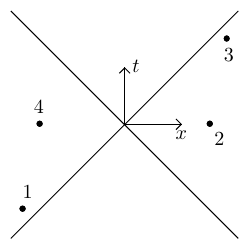
Figure 1. Regge limit, equivalent Figure 1 . Regge